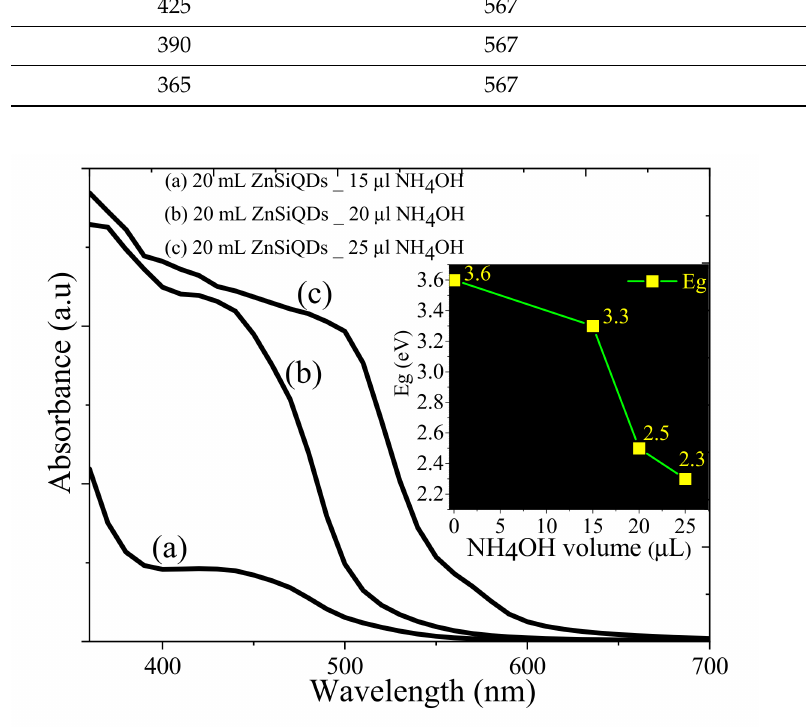
Figure 13. UV–vis absorbance of the colloidal ZnSiQD suspension in acetone synthesized with NH 4 OH of ( a ) 15 µ L ( b ), 20 µ L, and ( c ) 25 µ L.